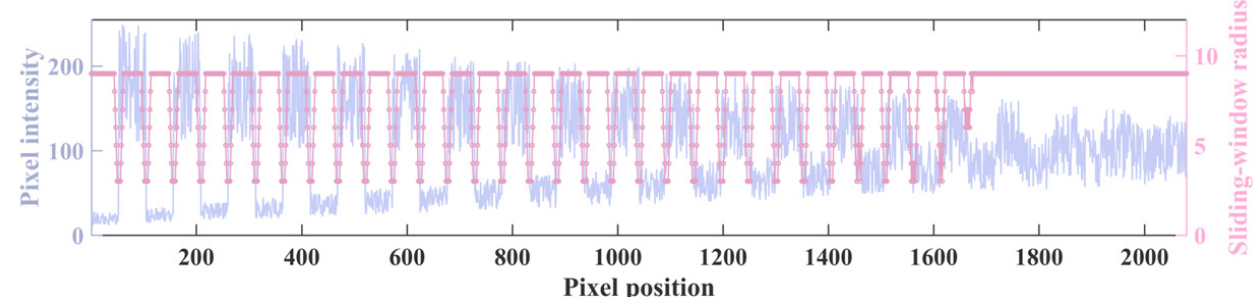
Figure 10. Comparison for the traditional weighting template and the guidance-aided adaptive weighting factor in the Frost filter: ( a ) is the comparison for the weight template in uniform region; ( b ) is the comparison for the weight template near the edge. The dotted squares represent the